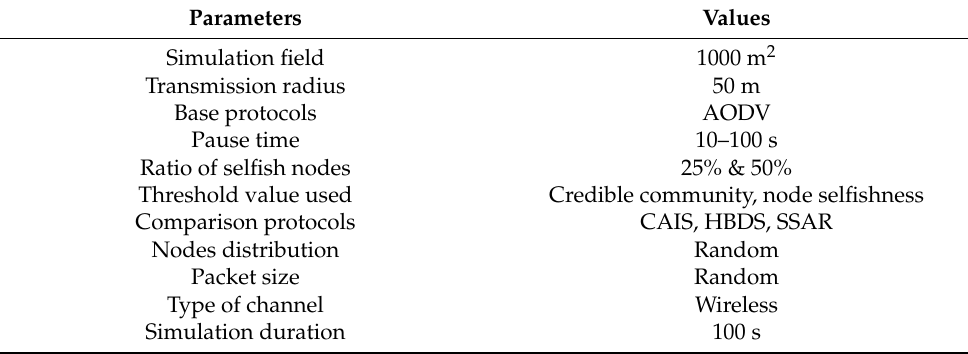
Table 4. Parameters used in the simulation.